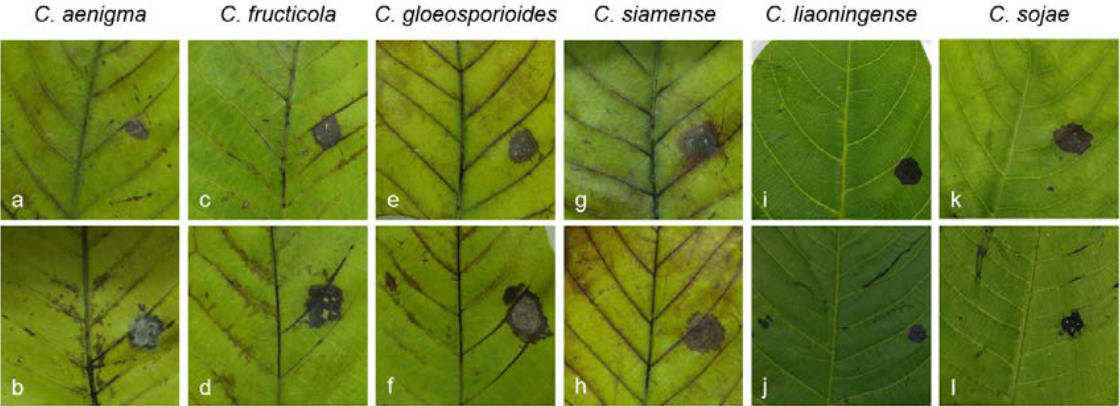
Figure 7. Pathogenicity of Colletotrichum species induced by inoculation of spore suspensions under wounded conditions. ( a ) DGZ1071. ( b ) JF2391. ( c ) JZ1121. ( d ) XGZ1021. ( e ) JF1021. ( f ) PG1021. ( g ) JF2011. ( h ) XQY1021. ( i ) and ( j ) XGZ3011. ( k ) and ( l ) XGZ3021.